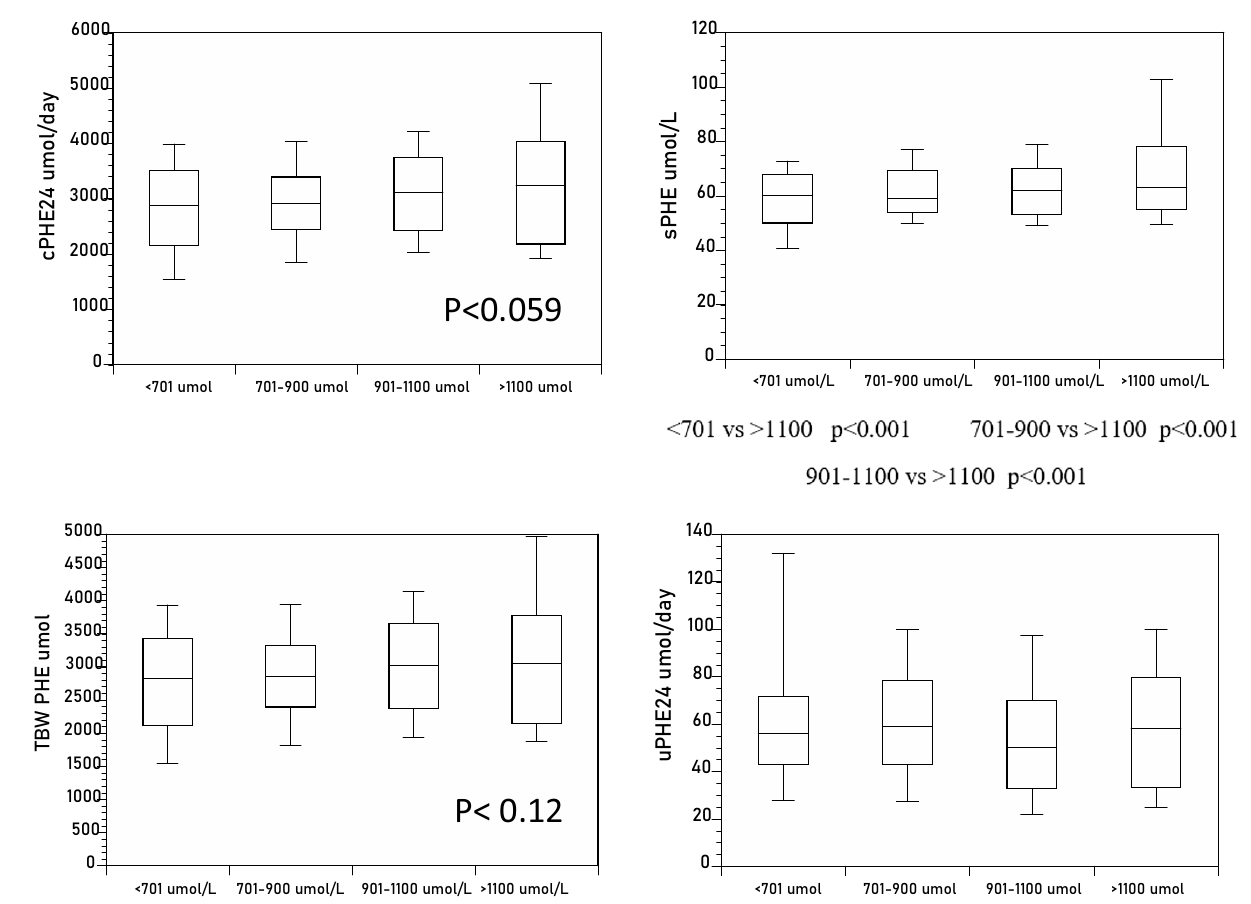
Figure 2. Differences in sPHE, uPHE 24 , tbwPHE, and cPHE 24 across the sTYR groups of < 701, 701–900, 901–1100 and > 1100 µmol/L ( p values indicated for within-group comparison where statistical significance was